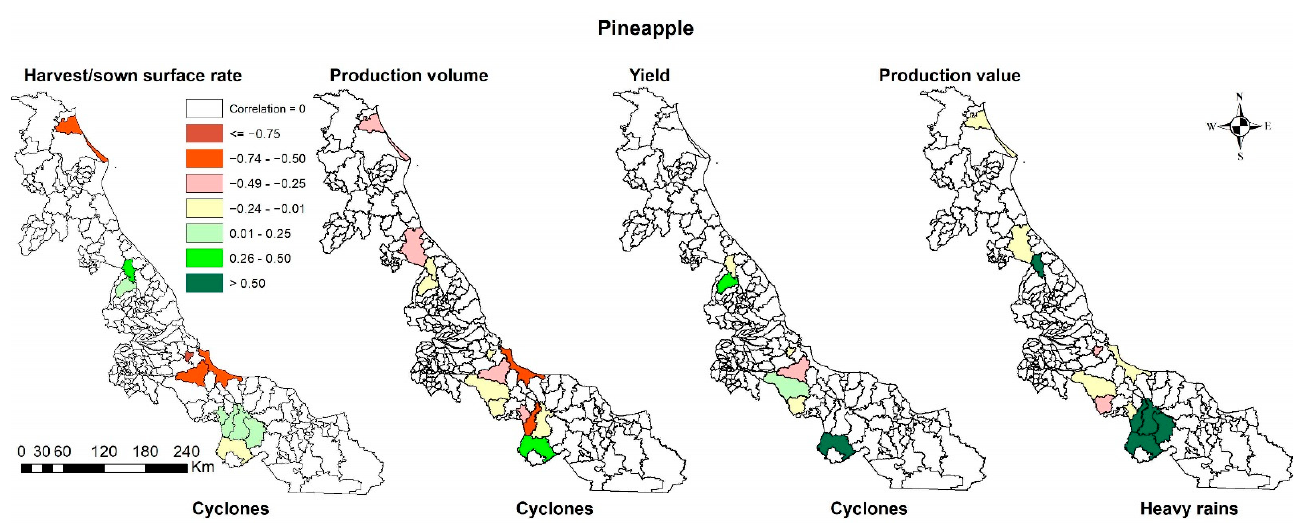
Figure 11. Pineapple crop data correlated with disaster declarations in the municipalities of the State of Veracruz from 2003 to 2020. Correlation = 0: sites with no correlation with phenomena. Source: projections based on data from the Mexican National Center to Prevent Disasters statistics [15] and the Mexican National Agrifood System [5].